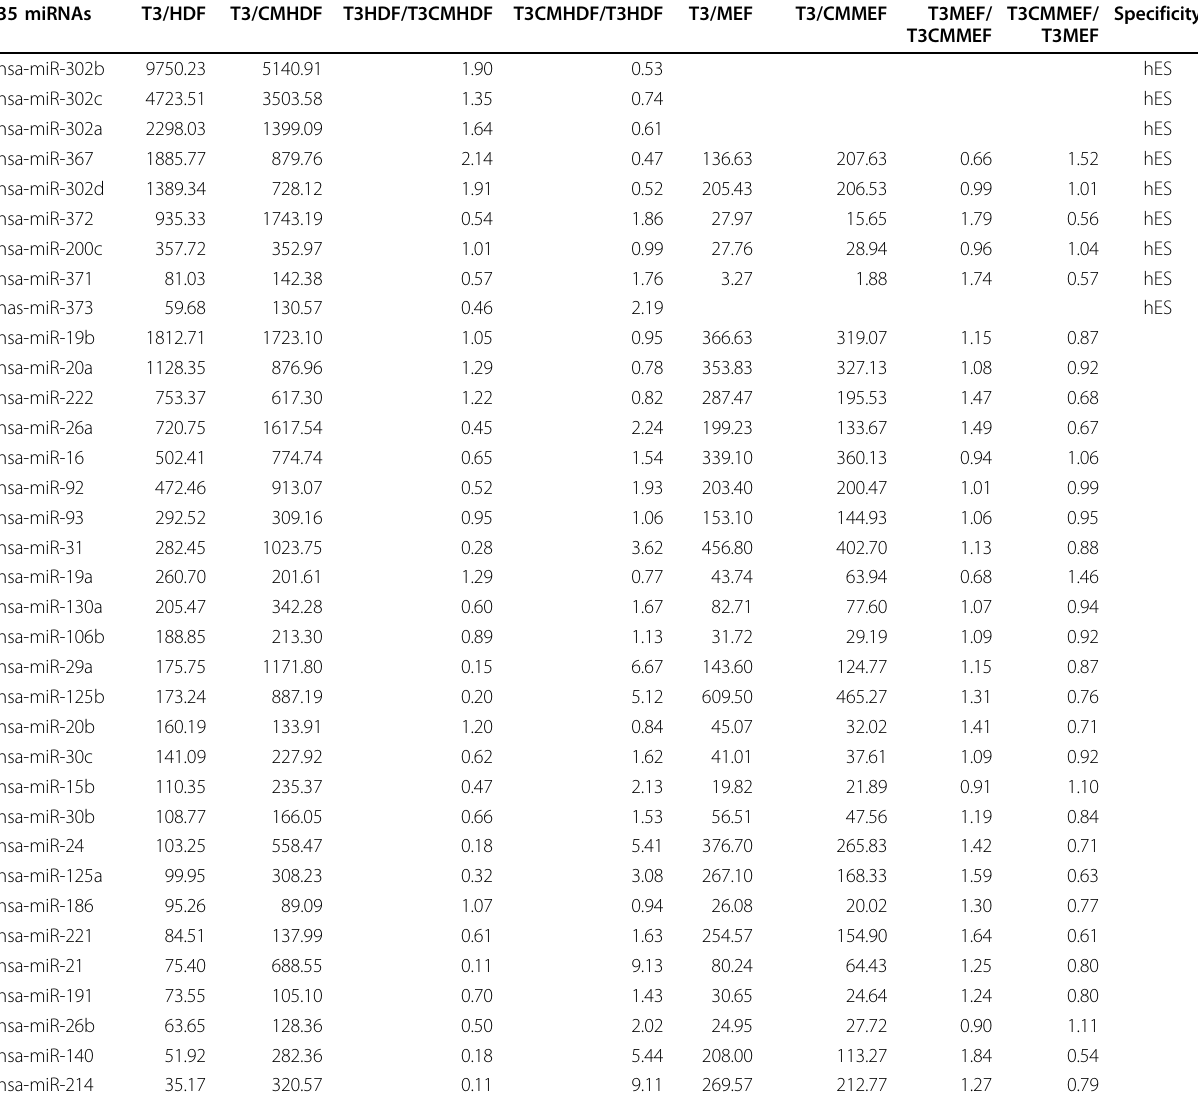
Table 2 The expression levels and fold-changes of 35/31 most abundantly expressed miRNAs 35